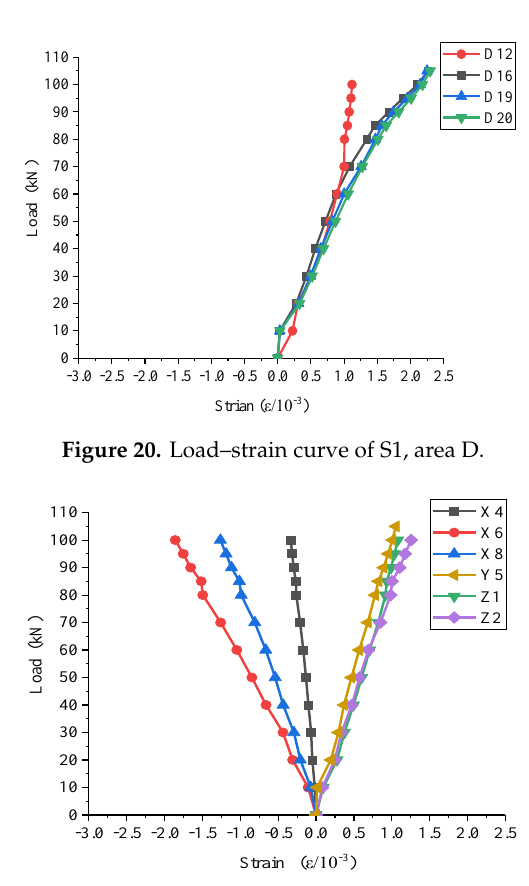
Figure 19. Load–strain curve of S1, area B.